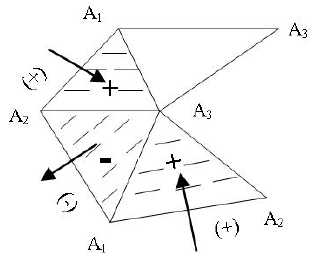
Figure 2. Oriented version of the Sperner